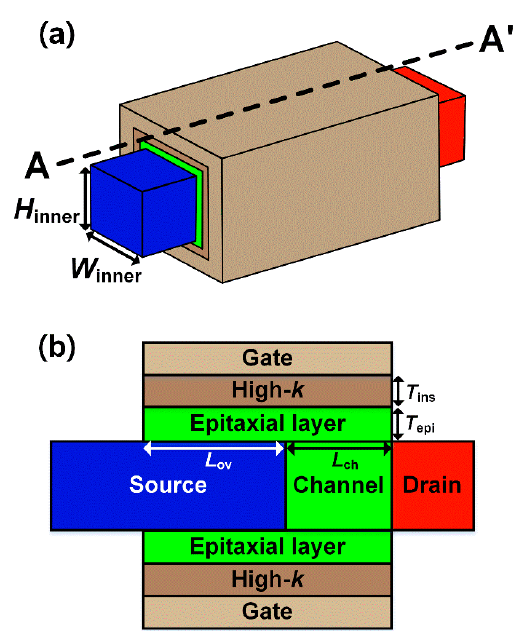
Figure 1. ( a ) Bird’s eye and ( b ) cross-sectional views of simulated gate-normal nanowire tunnel field-effect transistors (NWTFETs) with the normalized radius of curvature ( R norm ) of 0.